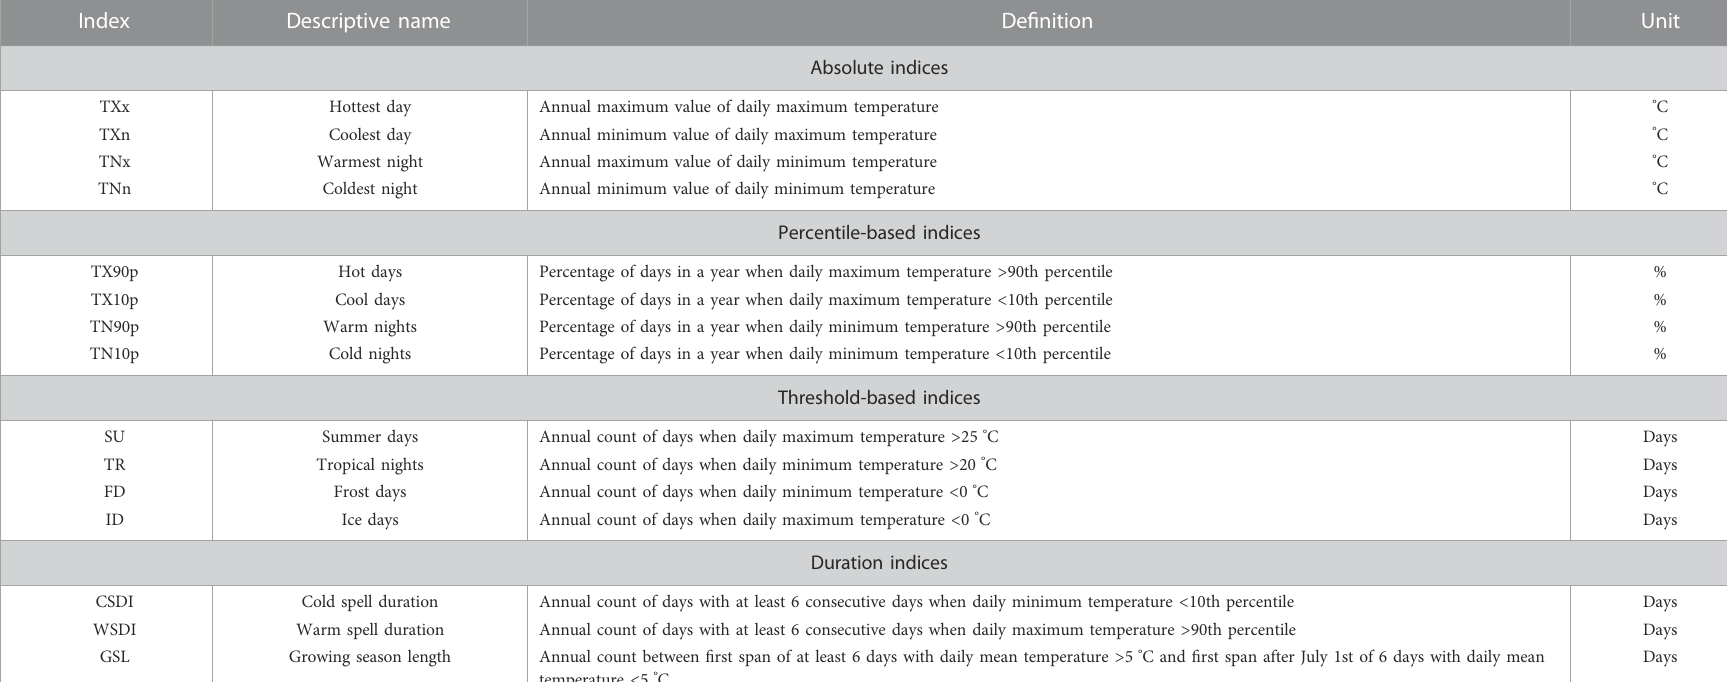
TABLE 1 De fi nitions of 15 ETCCDI temperature